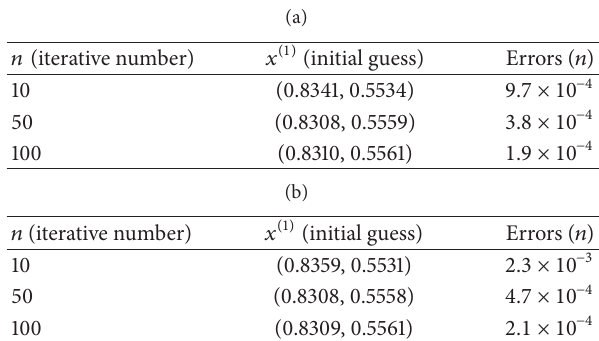
Table 3: (a) 𝑥 (1) = (1,1) ⊤ . (b) 𝑥 (1) = (1,1) ⊤